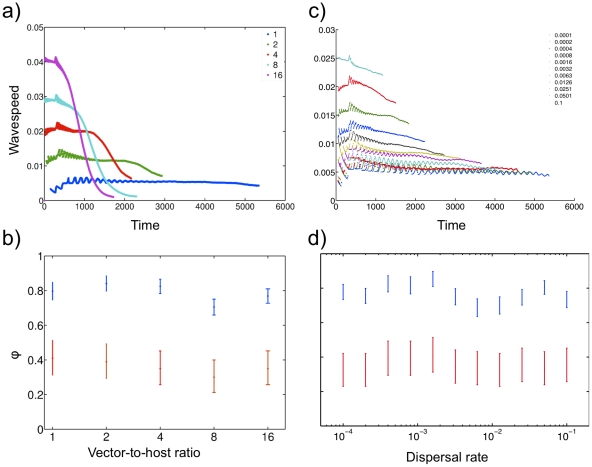
Sensitivity analysis of the wave speed to the ratio of vectors to hosts (m = N
V/N
R), and the local dispersal rate of hosts, in a heterogeneous lattice (p = 0.6).100 simulations at each parameter value were performed on a lattice over 6,000 time steps. Parameters used were those listed in Table 2. (a) Average wave-speed was calculated as the first difference of the square root area of the convex hull (encompassing all previous sites where infectious hosts exceeded the threshold value of 1%) smoothed by a moving average with a wave-length of 500 time steps. R
0 was calculated as 1.4, 2.0, 2.8, 3.9, and 5.6 for the vector-to-host ratios of 1, 2, 4, 8 and 16, respectively. Local dispersal rate was 0.01. (b) Average wave-speed trend (ratio of final and median wave-speed ; blue with error-bars representing the standard error) and frequency of realizations with (red with error bars representing 95% confidence intervals) at multiple vector-to-host ratios. The abscissa is on the log-scale. (c) Time-dependent estimates of wave speed of the pathogen at p = 0.6 at multiple dispersal rates. The constant ratio of vectors to hosts was set to 1. (d) Average trend of the final and the median wave-speed at multiple dispersal rates, with error bars showing standard error. Proportion of realizations with , with error bars showing the 95% confidence interval.